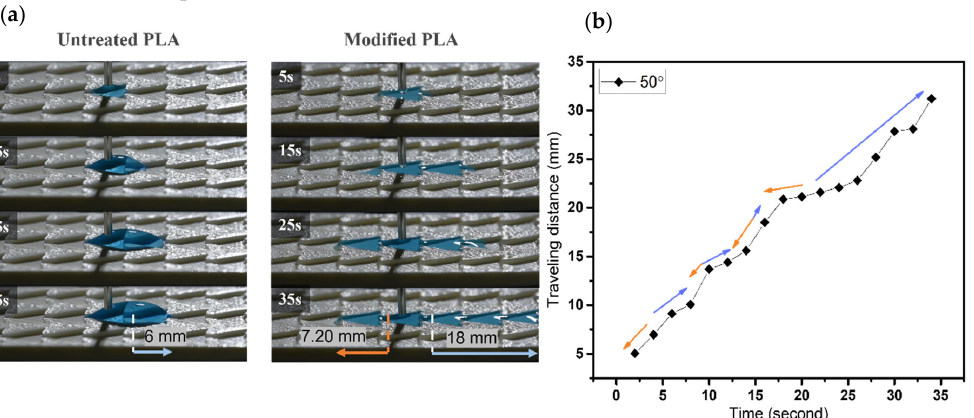
Figure 13. ( a ) The dynamic wetting behavior of water droplets in the 3D-printed dart-shaped pattern with β angle of 50 ◦ ; ( b ) Plot of traveling distance versus time with the directions of droplet movement wetting of modified pattern. The orange arrow denotes the opposite side, and the blue one denotes the predominant side.